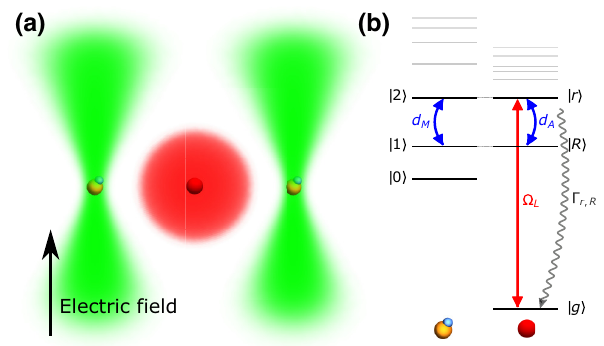
FIG. 1. Proposed experimental configuration and level scheme. (a) Two molecules are trapped in optical tweezers with an atom between them that can be excited to a Rydberg state. The tweezer holding the atom is turned off during the Rydberg excitation. (b) Level schemes (not to scale) of the molecule (left) and the atom (right). The atomic transition | r (cid:2) ↔ | R (cid:2) is tuned into resonance with the molecular transition | 1 (cid:2) ↔ | 2 (cid:2) by an electric field. The blue curved arrows represent transition dipole moments and the red arrow indicates the laser coupling. The faded levels indicate molecular and Rydberg states that are not needed for the gate but may result in van der Waals